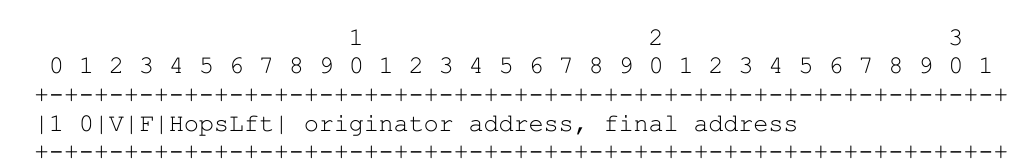
Figure 2. 6LoWPAN Mesh